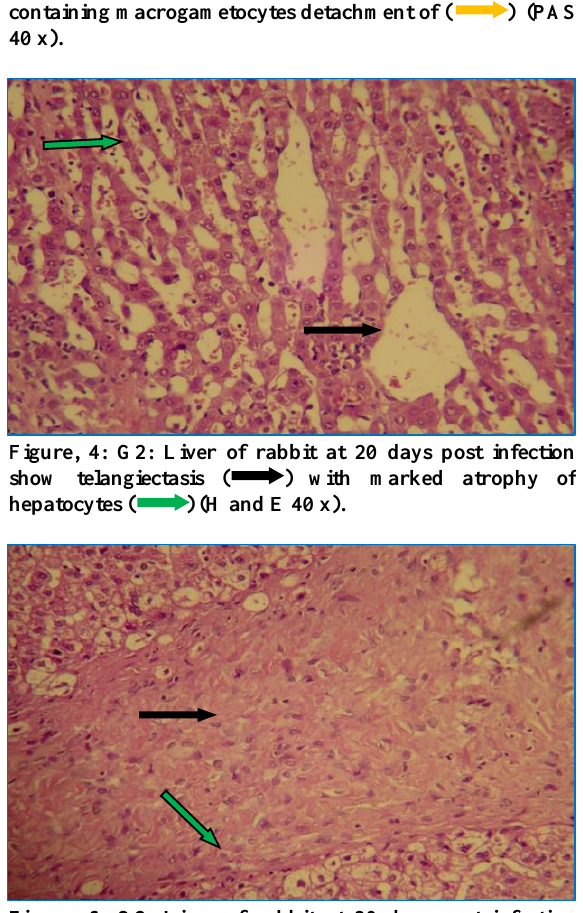
Figure, 2: G2: Liver of rabbit at 10 days post infection thickening of basement membrane ( ) over which basement membrane along